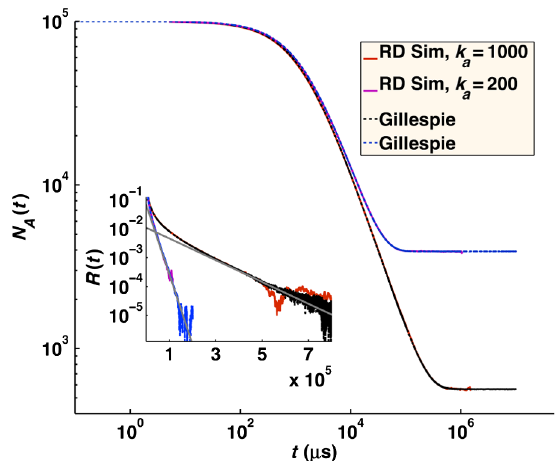
10. Pseudo-first-order reactions with a central A particle surrounded by a uniform distribution of B particles at densities B =V nm − 3 . (a) Concentration A ð t Þ of free A particles versus time, approaching the equilibrium value of A 0 simulations are in red, and show some error, with A sampled from the true propagator, black is the SCRTA solution [8], and dashed blue is the relaxation obeying chemical kinetics. (b) Relaxation R ð t Þ showing the approach to